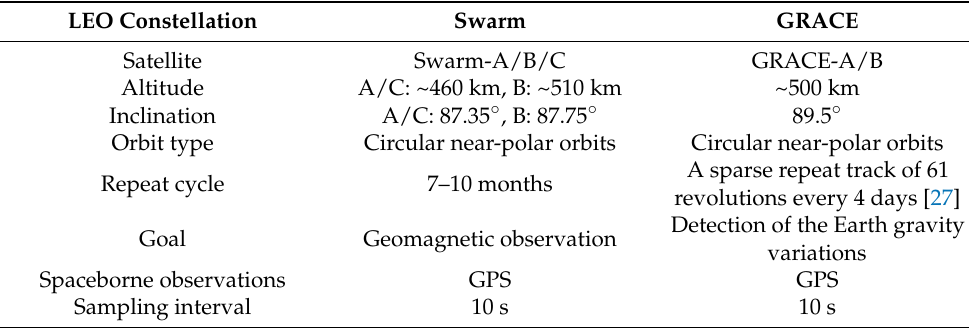
Table 1. Swarm and GRACE Constellation configurations.